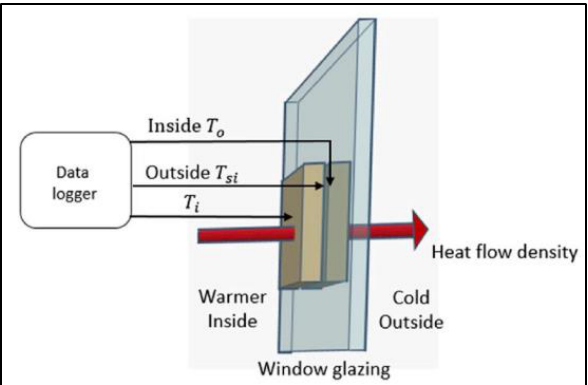
Figure 18. Typical Measurement Setup [32].